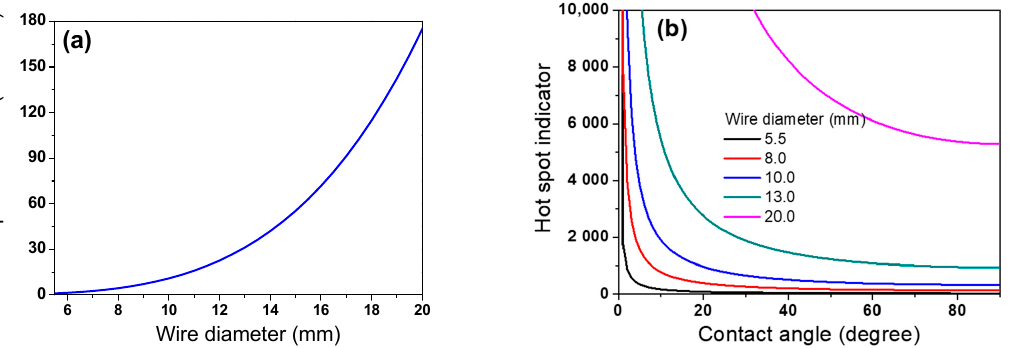
Figure 11. Variation of load by weight of upper wire ring as a function of wire diameter.